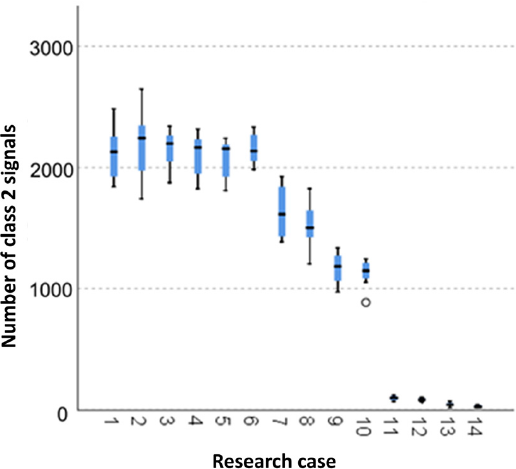
Figure 19. The graphical representation of the Kruskal–Wallis test results for independent tests of the number of class 2 signals.